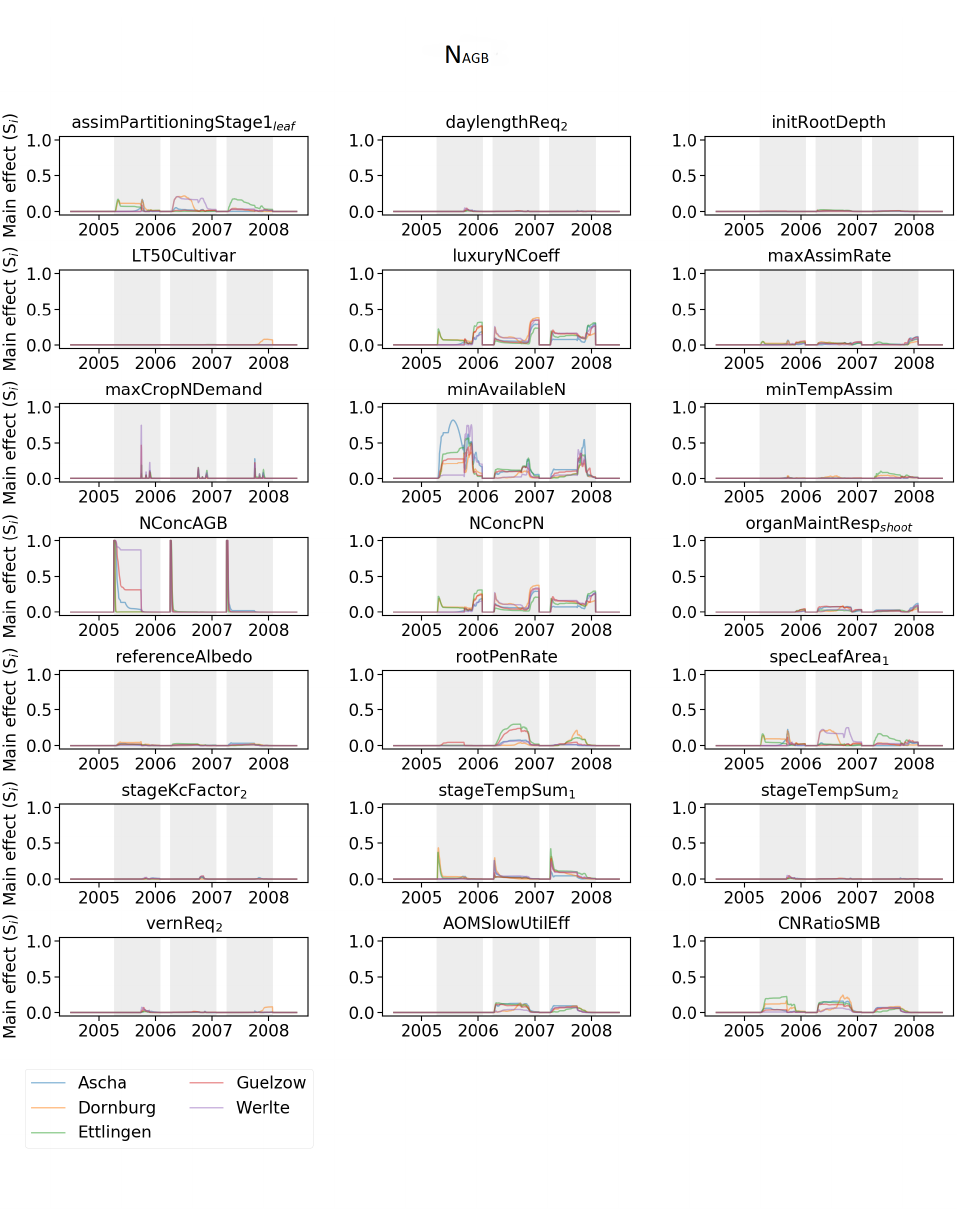
Figure A3. Daily S i values calculated using the extended FAST method for N AGB differentiated among the different